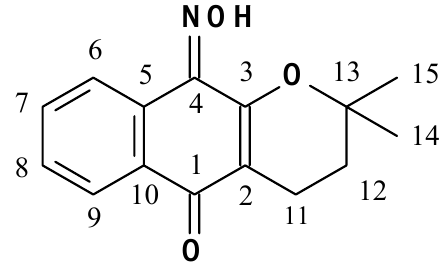
Figure 1. Structural scheme and numbering label for 1